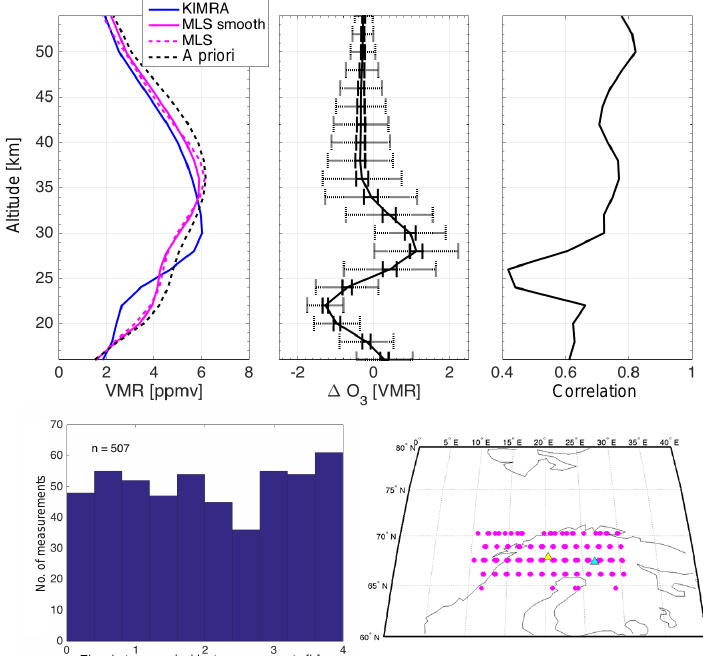
Figure 7. Upper row: the same as for Fig. 3, but for KIMRA–MLS. Both the average of the smoothed (used for comparison) and unsmoothed MLS profiles are shown here. Lower left: histogram of the time difference between coincident measurements. Lower right: map showing the locations of the coincident MLS measurements (magenta circles), Kiruna (yellow triangle), and Sodankylä (cyan triangle).